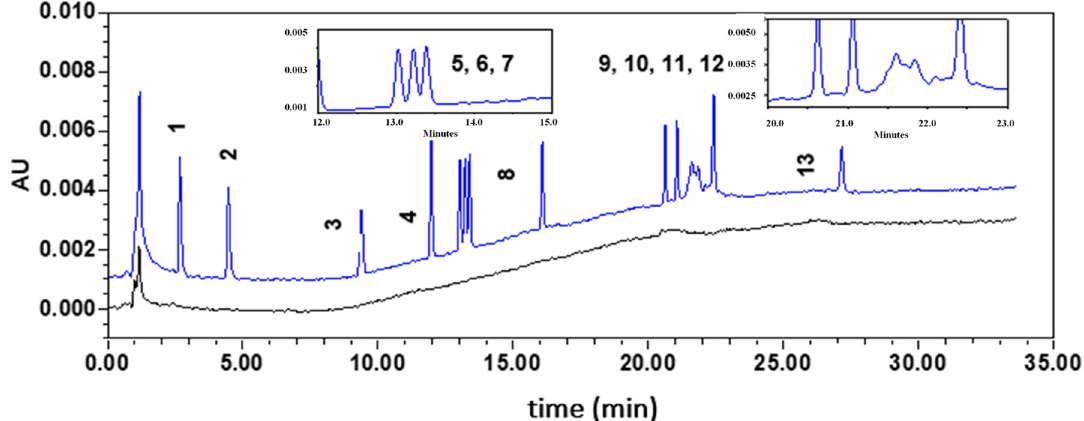
Figure 3. HPLC–DAD chromatograms of plasticizers investigated. Chromatograms of the first validation standard (blue) and a blank solution (CAL0; black). Compounds were eluted between 2.8 and 27.3 min according to the following order: (1) DMP, (2) DEP, (3) DPP, (4) DphP, (5) BBP, (6) DIBP, (7) DBP, (8) DCHP, (9) DEHP, (10) DNOP, (11) DINP, (12) DEHT, and (13) TOTM. Inserted chromatograms correspond to a zoom of the 12–16 min and 20–23 min periods.